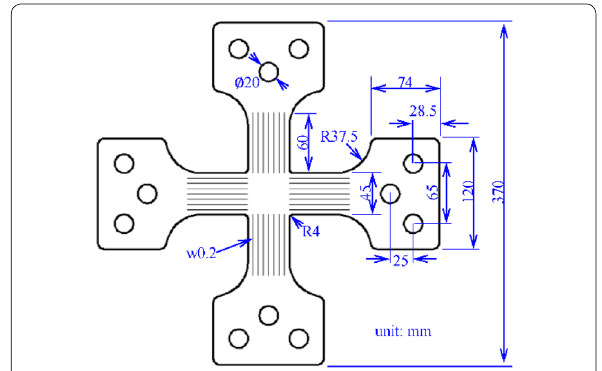
Figure 4 Dimensions of cruciform specimens in biaxial tensile testing (mm)